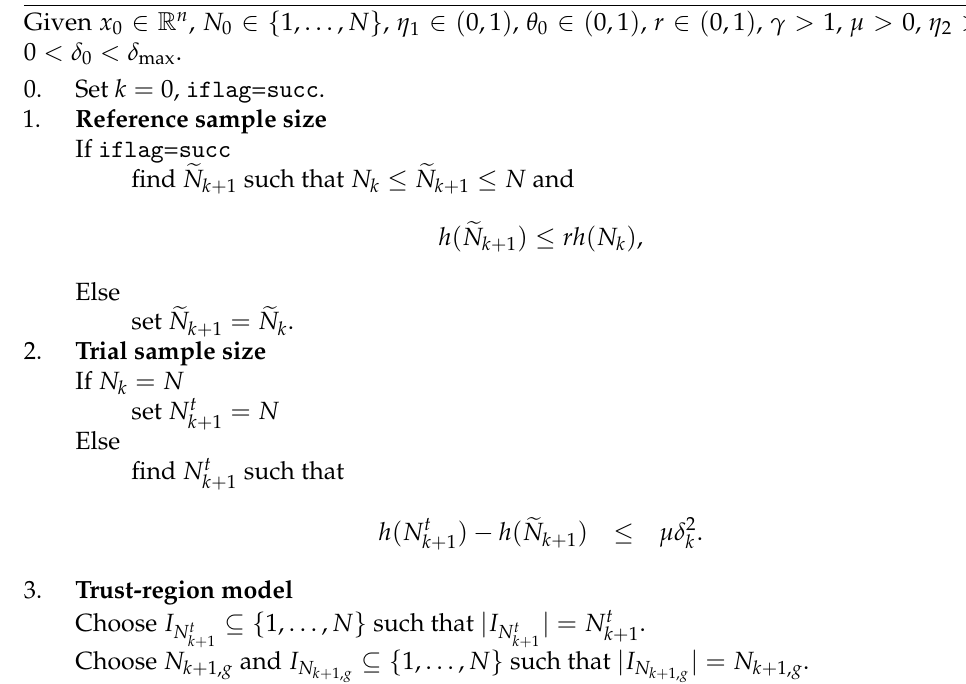
Algorithm 1 Stochastic Inexact Restoration Trust-Region